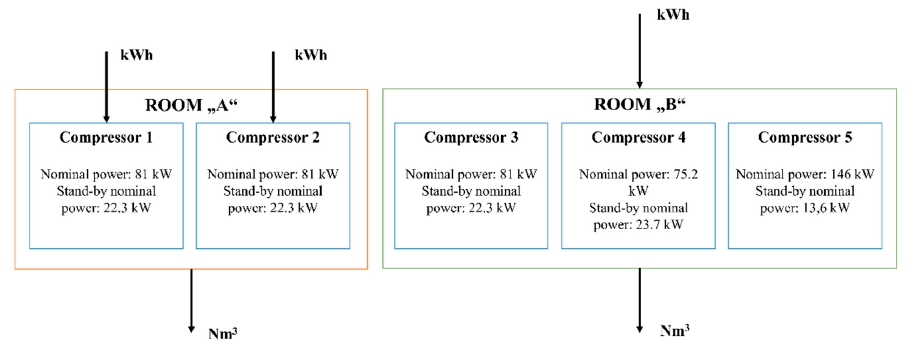
Figure 4. Scheme of compressors’ groups and main data available.